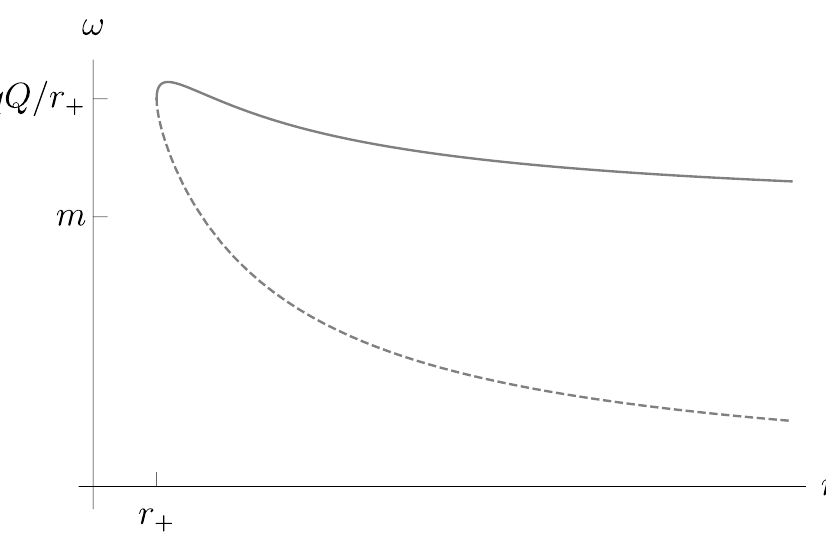
Figure 4 . The region in the ! { r plane in which there exists a tunnelling barrier, in the large m limit. The dotted line corresponds to energies less than q (cid:8) | in this regime, there is always a barrier to emission. For a small range of energies greater than q (cid:8), however, there also exists a barrier to